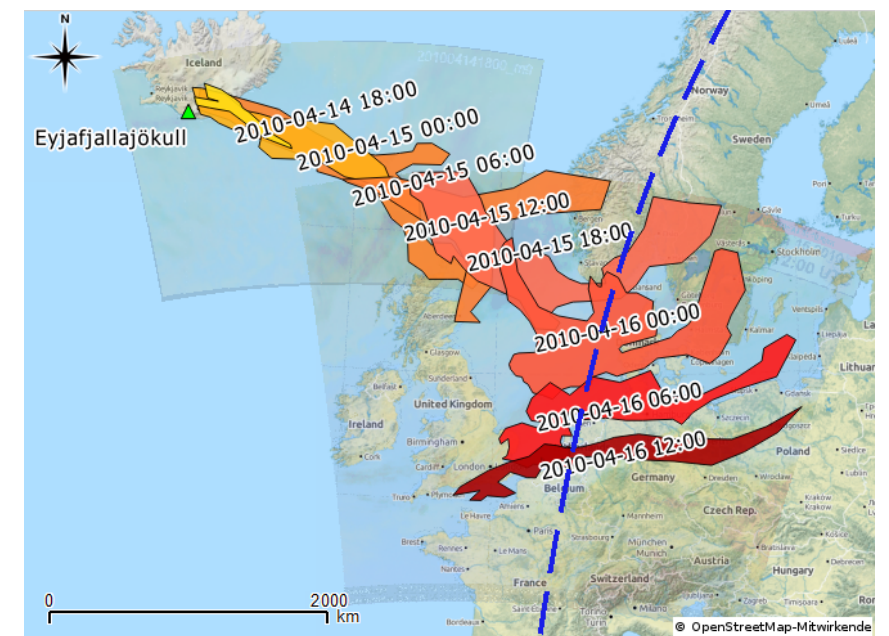
Figure 1. Distribution and transport of volcanic ash over northwest Europe sketched using georeferenced satellite images (Meteosat-9, Dust). After georeferencing, the ash layers were retraced as colored polygons, where the color of the polygons (yellow to red) represent consecutive time steps (Strohbach, 2015). The blue dashed line indicates the flight track of CALIPSO during 17 April 2010 (measurement shown in Fig.